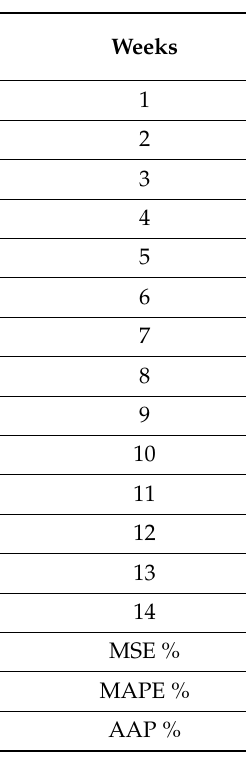
Table 5. Simulation models of WCR in